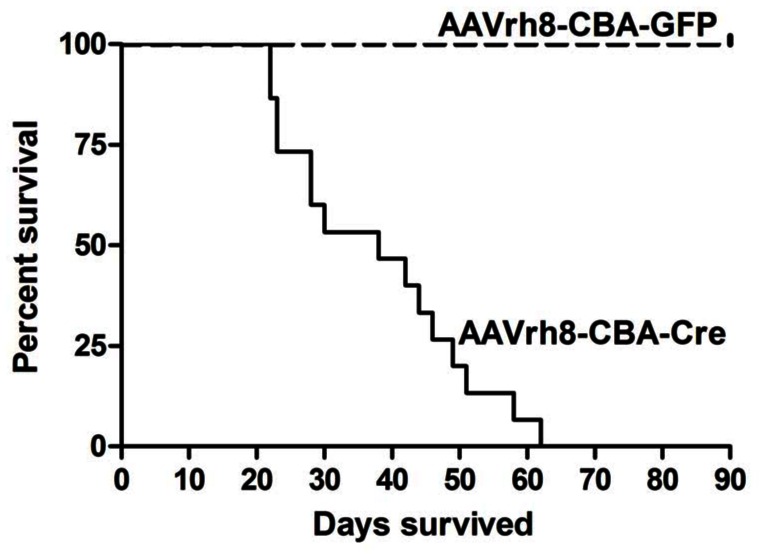
Survival of Tsc1c/c mice injected ICV with AAVrh8-CBA-GFP or AAVrh8-CBA-GFP at P0.Survival is shown for Tsc1c/c pups injected with the AAV-Cre (N = 15) or the AAV-GFP (N = 13) vectors as a control, both at 2×1010 g.c. per 2 µl into each ventricle. Median survival of the Cre injected mice was 38 days; controls survived >90 days. Difference between groups p<0.0001.